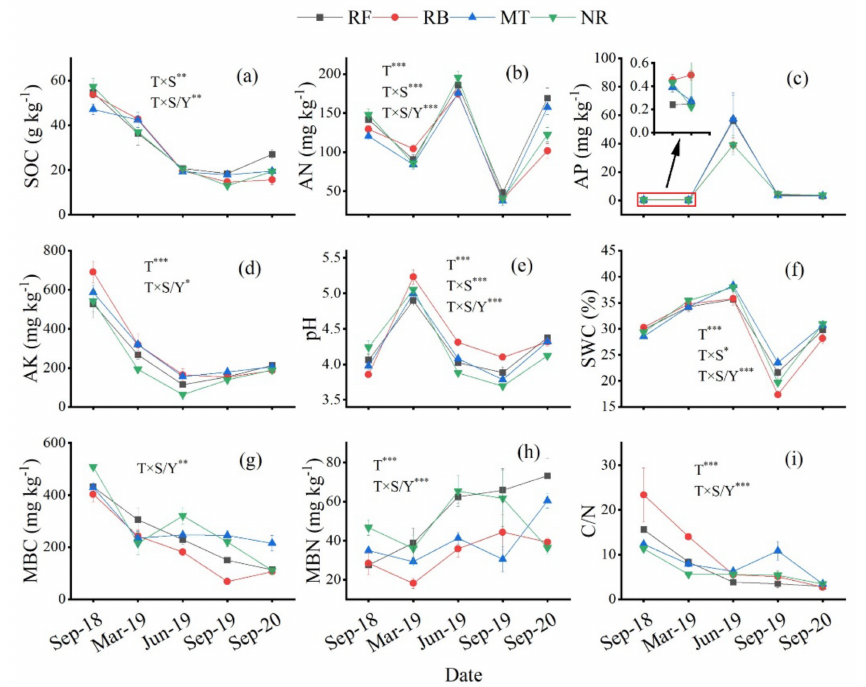
Figure 2. Dynamic characteristics of soil physical and chemical properties and microbial biomass under different harvest residue treatments from 2018 to 2020. RF, reference; RB, residual burning; MT: mulching treatment; NR, no residuals; ( a ) SOC, soil organic carbon; ( b ) AN, available nitrogen; ( c ) AP, available phosphorus; ( d ) AK, available potassium; ( e ) pH, potential of hydrogen; ( f ) SWC, soil water content; ( g ) MBC, microbial biomass carbon; ( h ) MBN, microbial biomass nitrogen; ( i ) C/N, MBC/MBN. Data are displayed as means ± standard errors. T, treatment; S, season; Y, year; T × S, the interaction between T and S; T × S/Y, the interaction between T and Y; * p < 0.05; ** p < 0.01; *** p < 0.001.